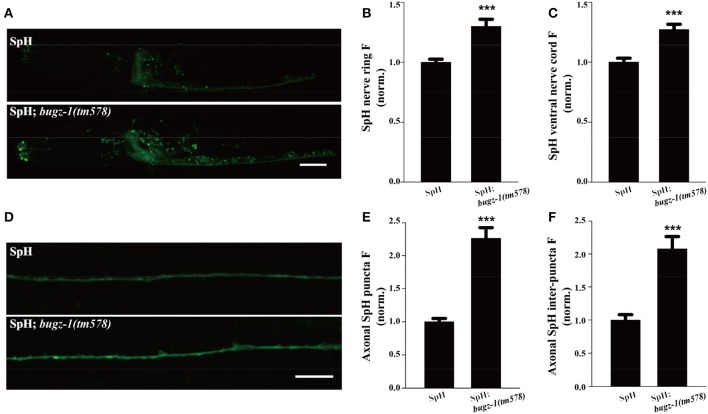
bugz-1(tm578) show synaptic vesicle endocytosis defect. (A) Representative images of SNB-1::pHluorin (SpH) in the nerve ring and ventral nerve cord in wild type and bugz-1(tm578) mutant animals. (B,C) Quantification of fluorescence in the nerve ring (B) and ventral nerve cord (C) of bugz-1(tm578) mutant normalized to the wild-type control. n ≥ 14. (D) Representative images of SpH in the dorsal nerve cord in wild type and bugz-1(tm578) mutant animals. (E,F) Quantification of axonal puncta fluorescence (E) and inter-puncta fluorescence (F) of dorsal nerve cord in mutant normalized to the wild-type control. n ≥ 7. Values that significantly differ from controls are indicated (***p < 0.001 by two-tails Student's t-test). Error bars represent SEM. Scale bars indicate 10 μm in (A) and 20 μm in (D).